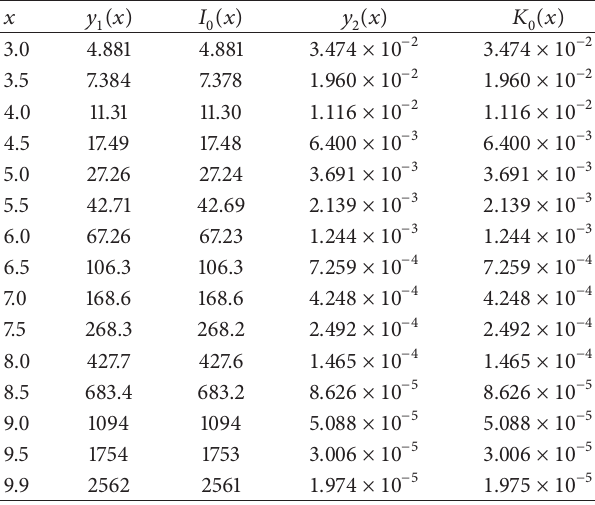
Table 5: Comparisons between the solution of Example 2 obtained with known modified Bessel functions and that calculated in this study.